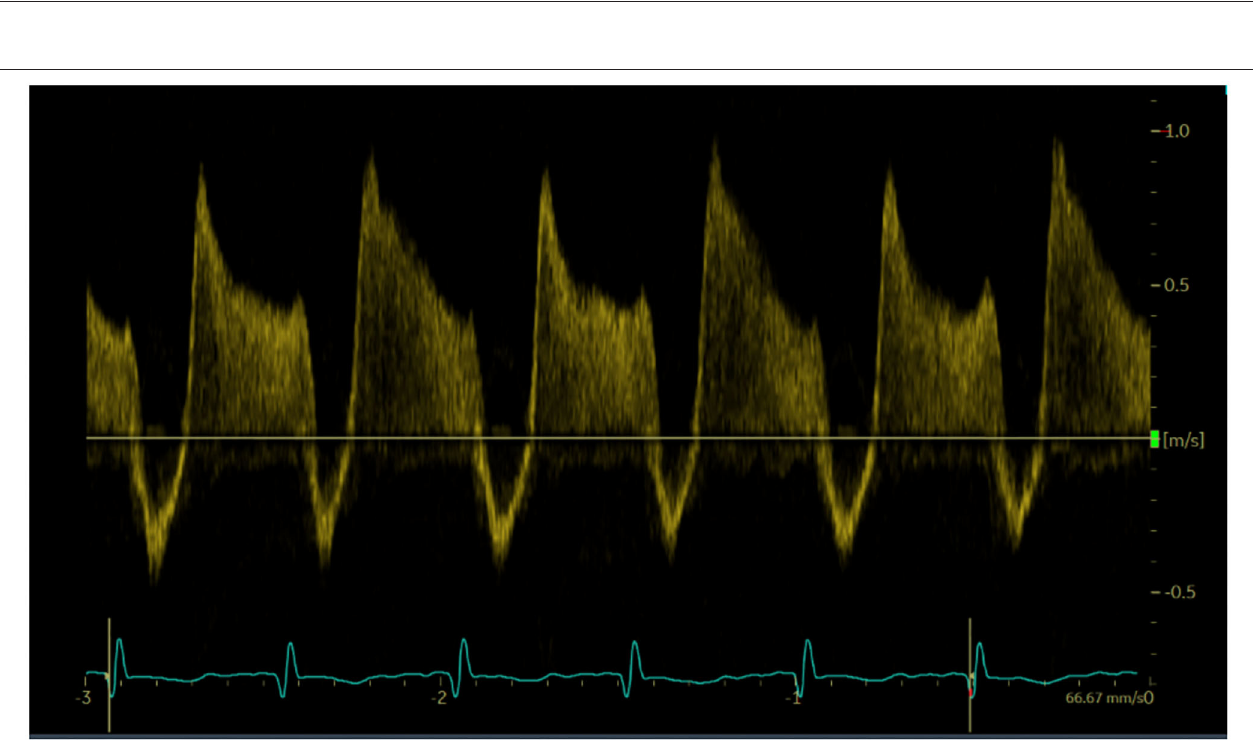
FIGURE 2 | Doppler pulse wave measurements of ductus arteriosus flow. Three consecutive flows profiles were used to average measurements.